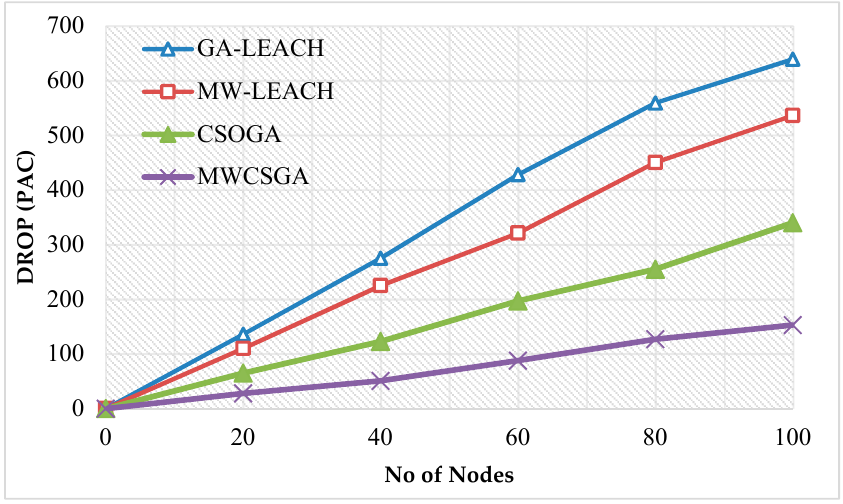
Figure 12. Packet drop calculation.